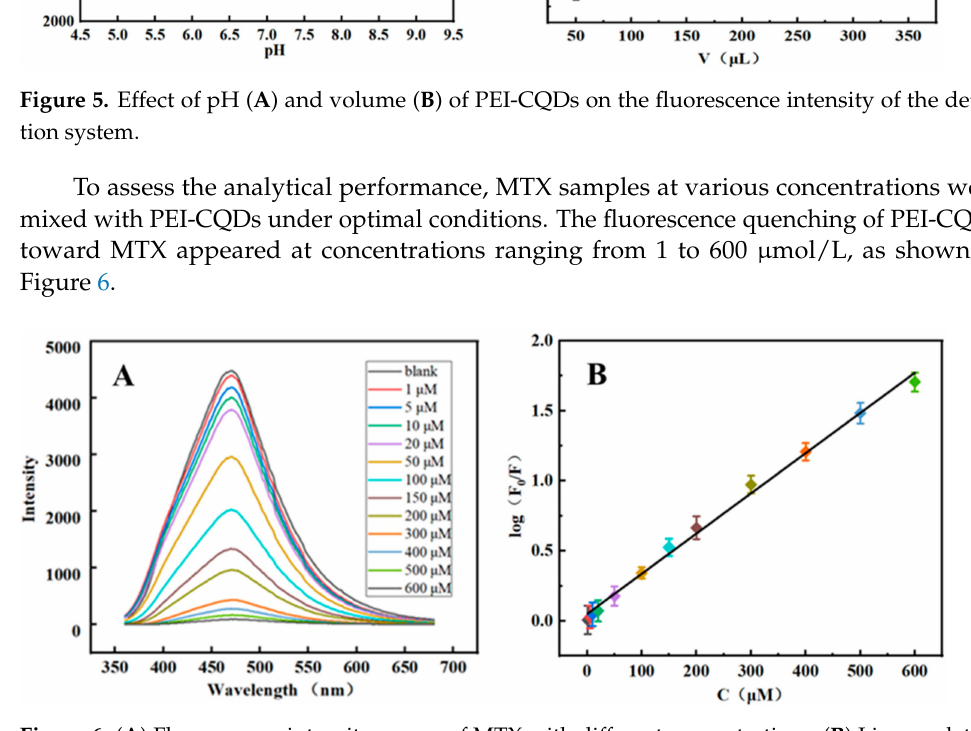
Figure 6. ( A ) Fluorescence-intensity curves of MTX with different concentrations; ( B ) Linear relation curve of log (F 0 /F) and concentration of